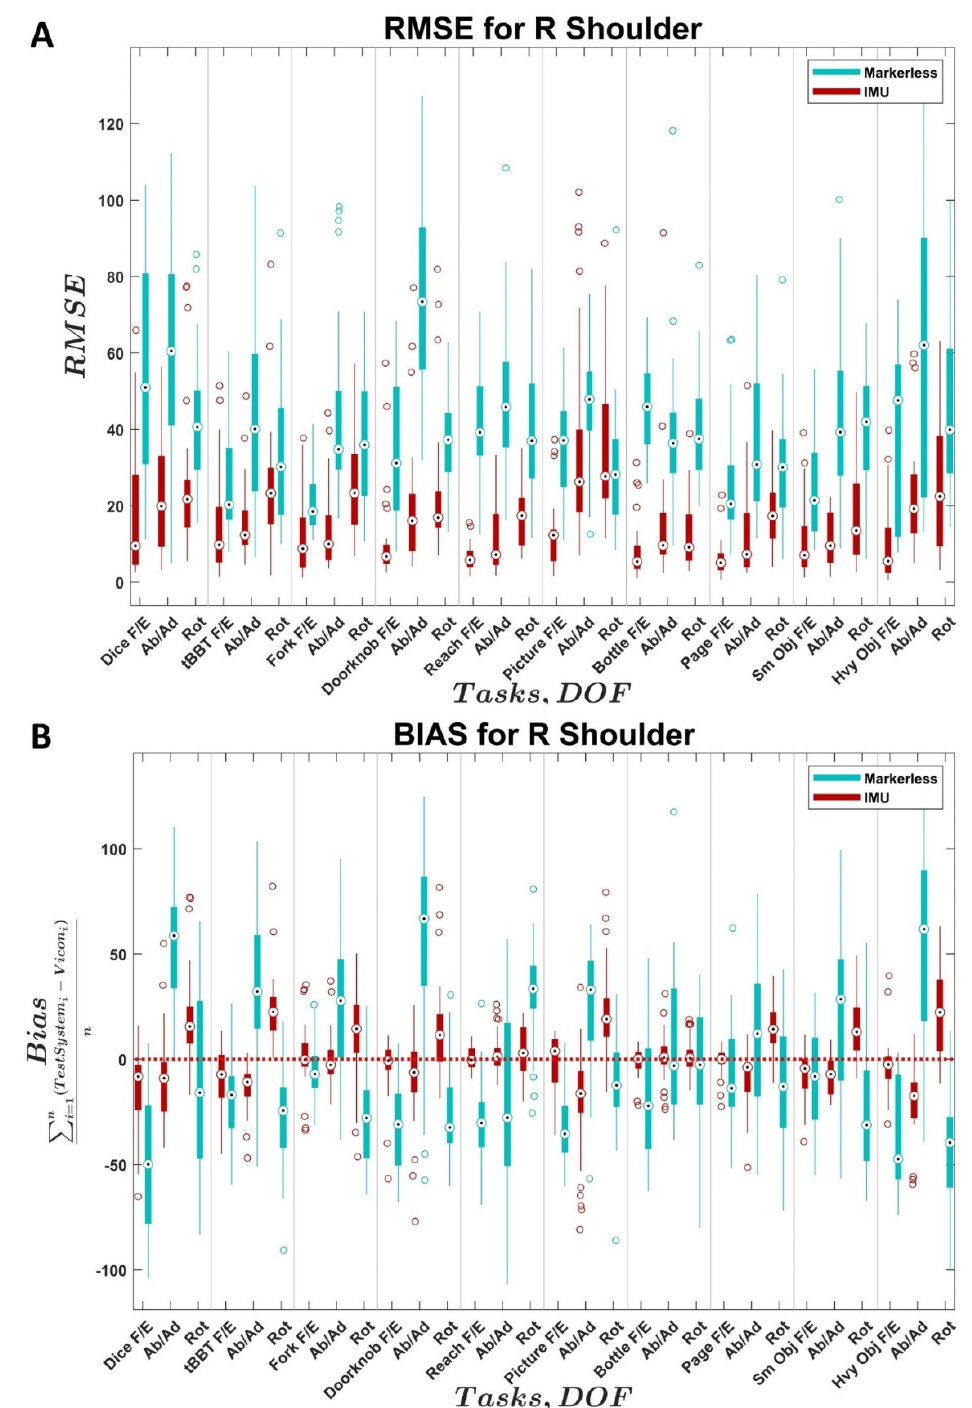
Figure 3. Distributions of ( A ) right shoulder joint angle RMSE and ( B ) right shoulder joint angle bias across subjects for the IMU system (Xsens Awinda MTw, El Segundo, CA, USA) and markerless system (Kinect, Microsoft, Seattle, WA, USA) compared to the reference system (VICON, Oxford, UK). X-axis identifies the task and associated joint angle. F/E = flexion/extension, Ab/Ad = abduction/adduction, LaF = lateral flexion, Rot = rotation. Black dots indicate medians, empty circles indicate outliers, bold line indicates quartiles, and whiskers indicate non-outlier maximums and minimum.